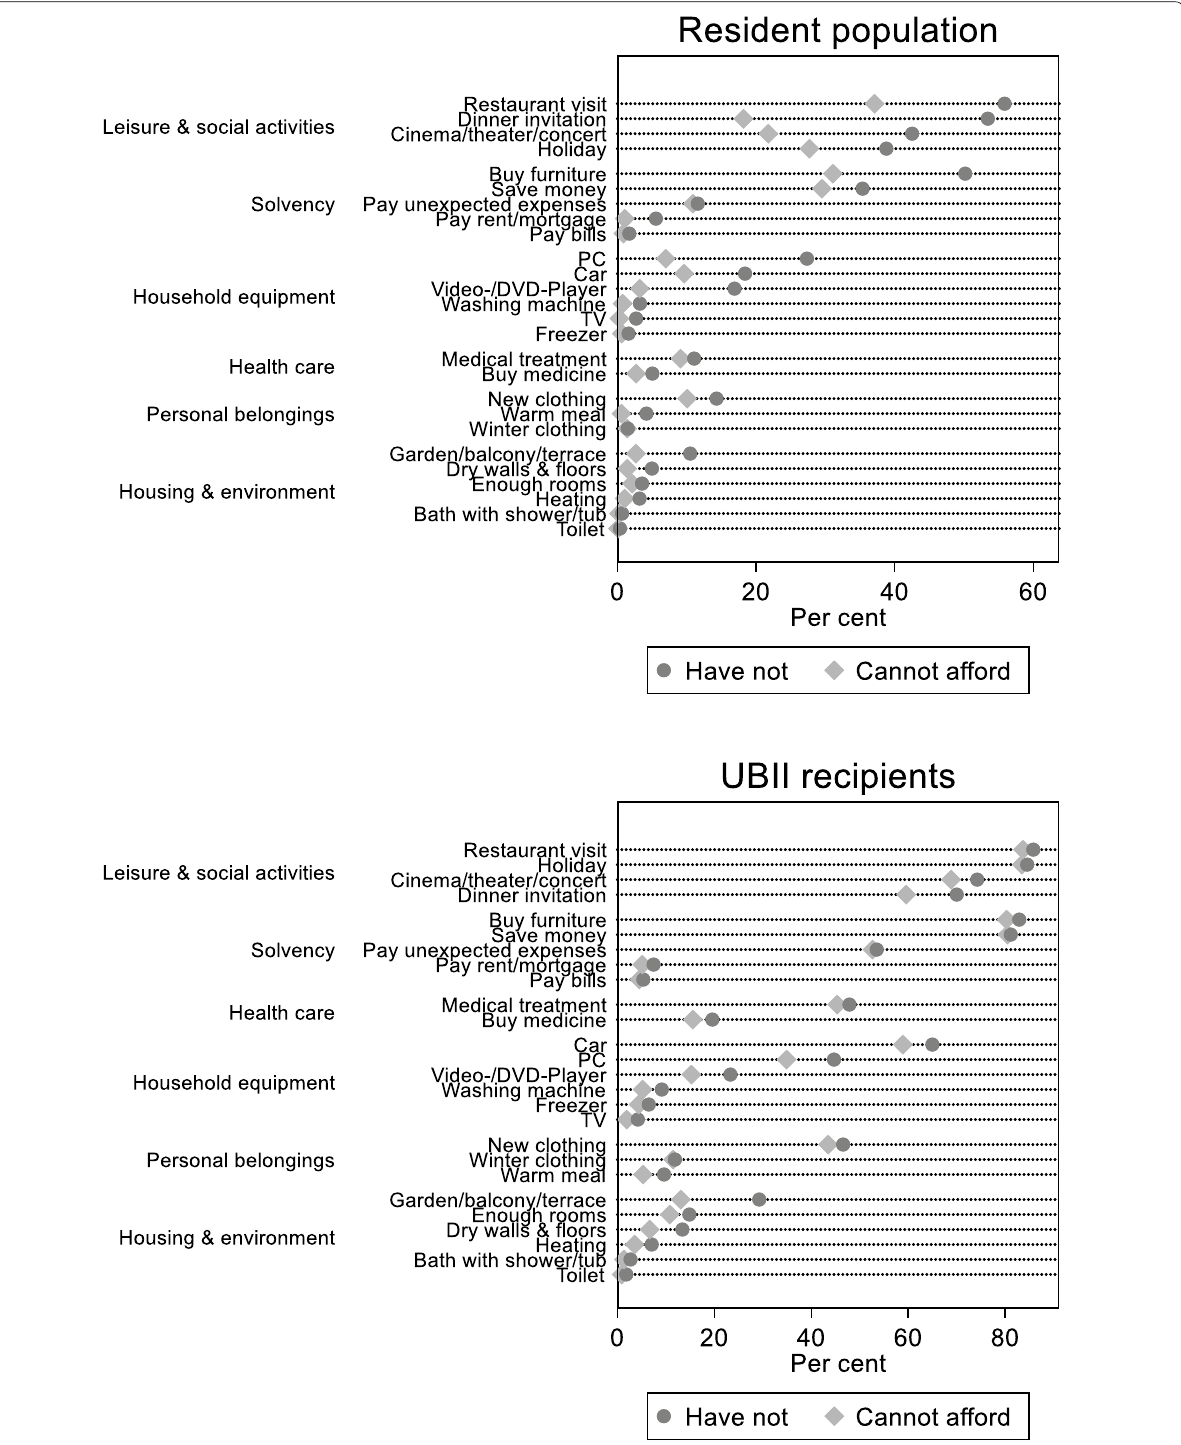
Fig. 1 Percentage of respondents not having the item (“Have not”) and not being able to afford the item (“Cannot afford”). Data: Panel Study Labor Market and Social Security (PASS) samples 1, 2, 6, and 7; waves 1–7, 2006–2013. Weighted analyses controlling for survey design, selection probabilities, and